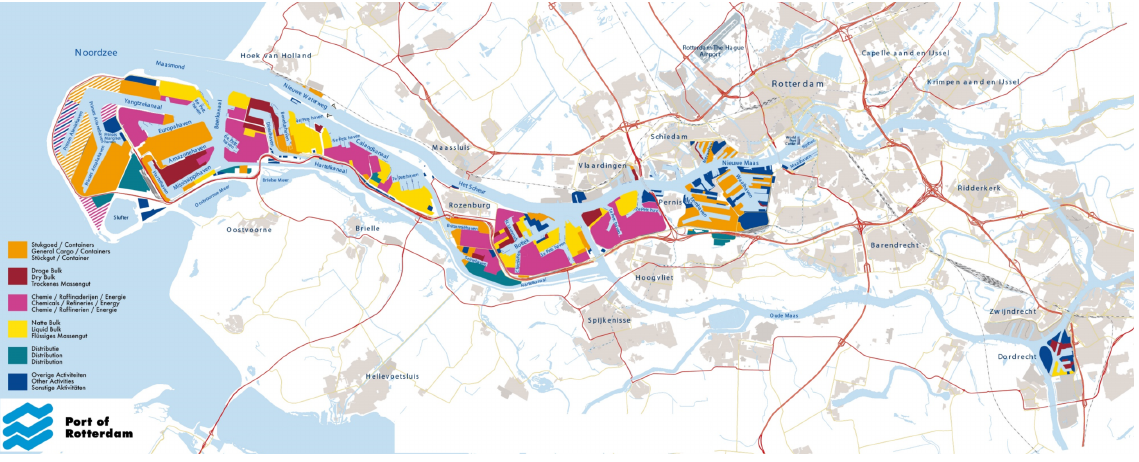
Figure 2. Port of Rotterdam.